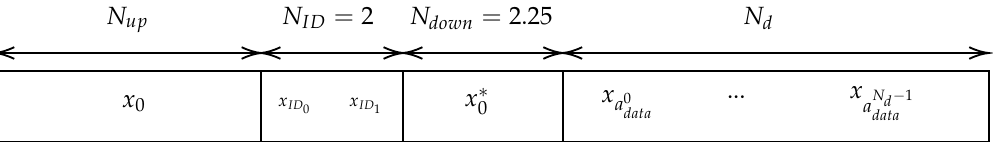
Figure 2. The legacy LoRa frame